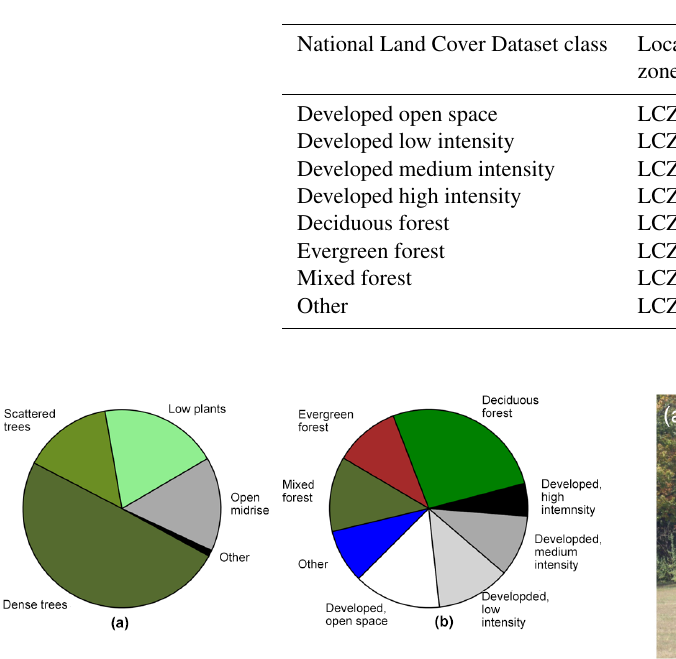
Figure 2. Distribution of land cover types at Goddard Space Flight Center. (a) Amount of area as determined by Stewart and Oke local climate zones; (b) amount of area as determined by the National Land Cover Dataset (NLCD).